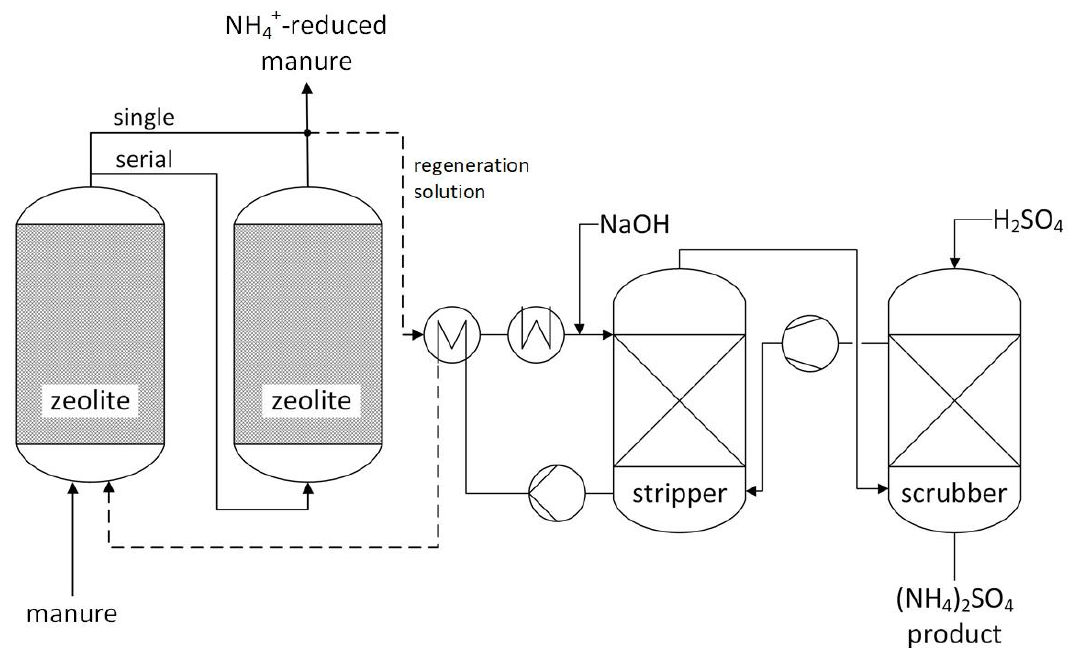
Figure 2. Principle flowchart of the ILS-pilot plant (treatment capacity: 500 – 1000 L h −1 ) and the different operation modes of the ion exchanger columns (single/serial).